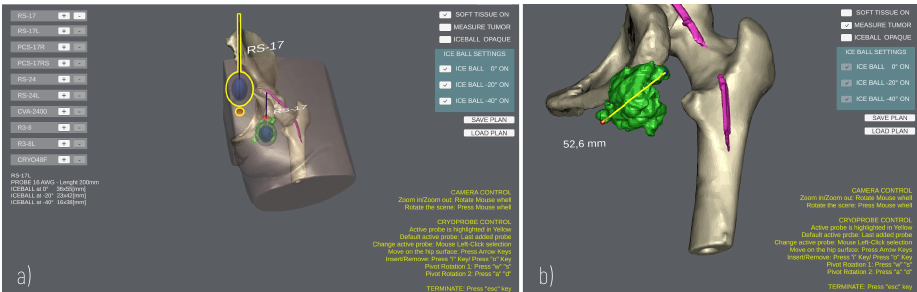
Figure 4. GUI during a planning. ( a ) Planning the positioning of two Cryoprobe. The “active” Cryoprobe is highlighted in yellow; ( b ) Example of measurement performed to evaluate the size of a